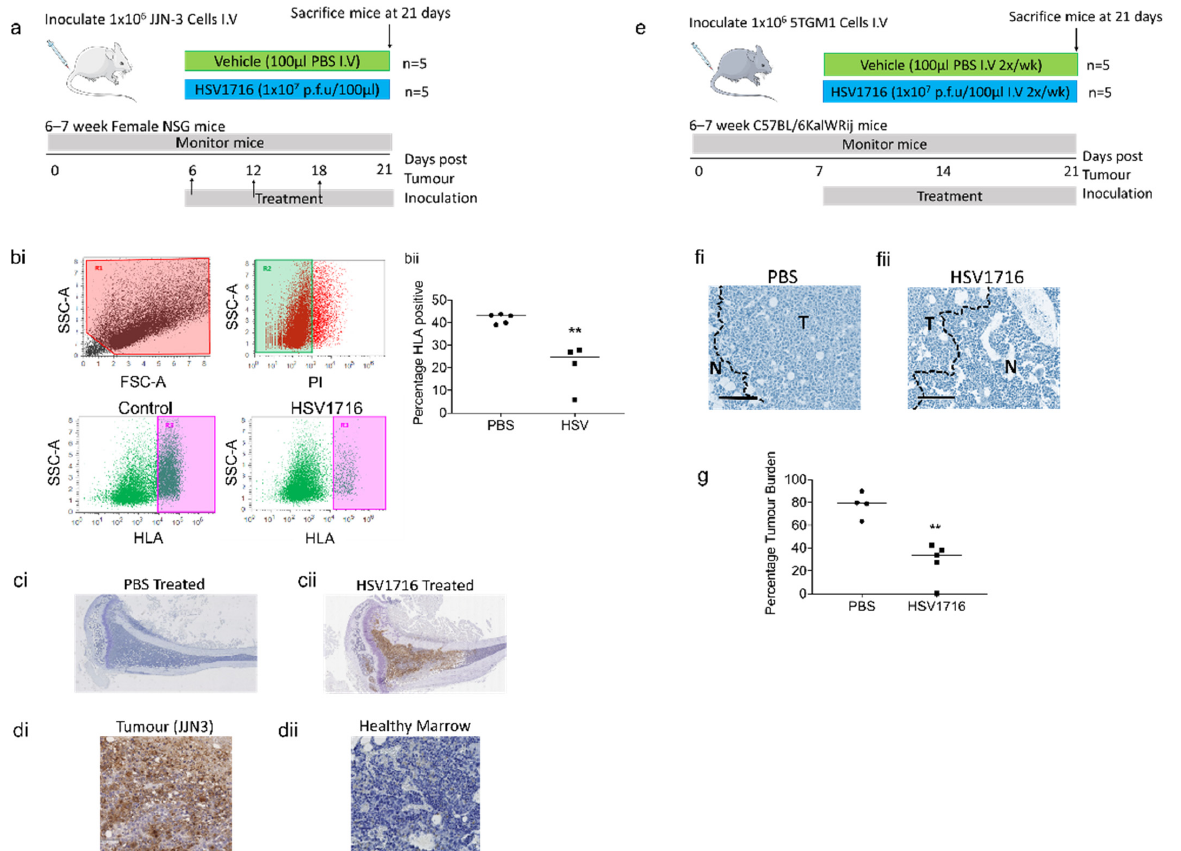
Figure 3. HSV1716 therapy significantly reduces tumor burden in murine models of myeloma.